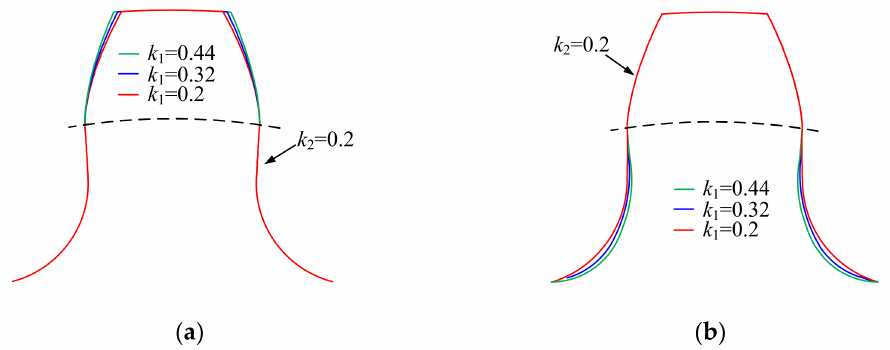
Figure 10. Effect of parabolic coefficient k 1 on the tooth profile of the novel gears. ( a ) Tooth profile of the pinion; ( b ) Tooth profile of the gear.